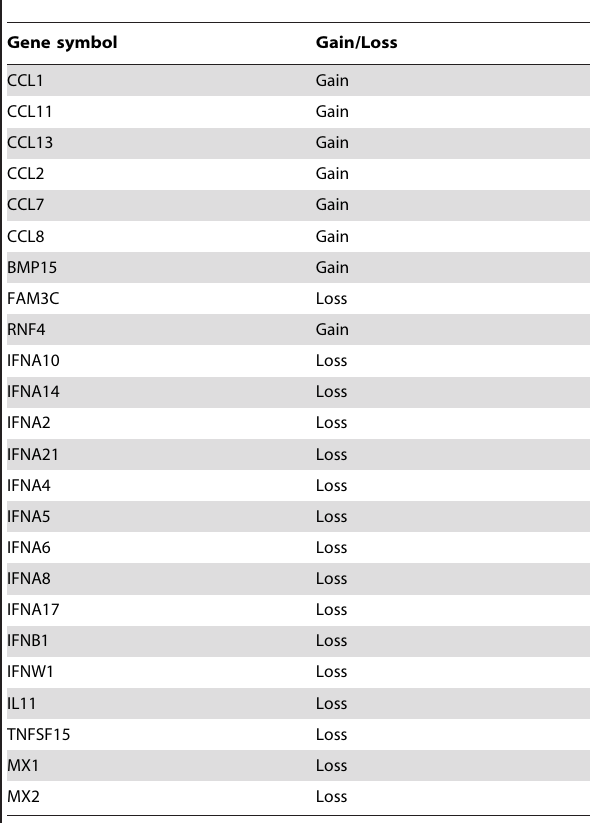
Table 1. Copy number gain or loss in the iCNV-5 genes.